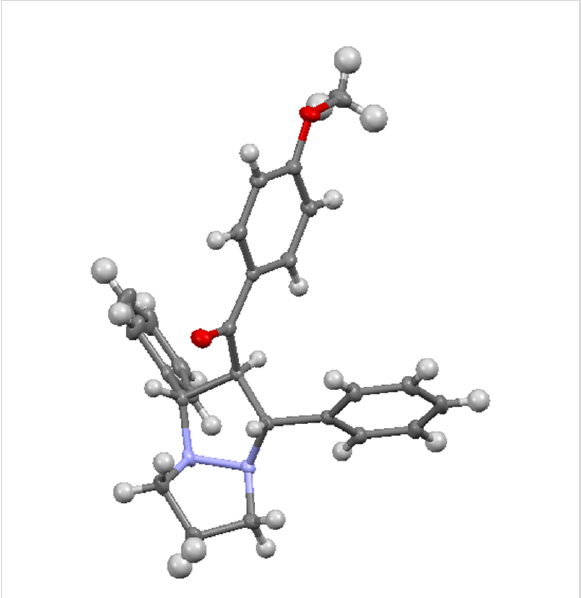
Figure 1: Single-crystal X-ray structure of compound 3e .